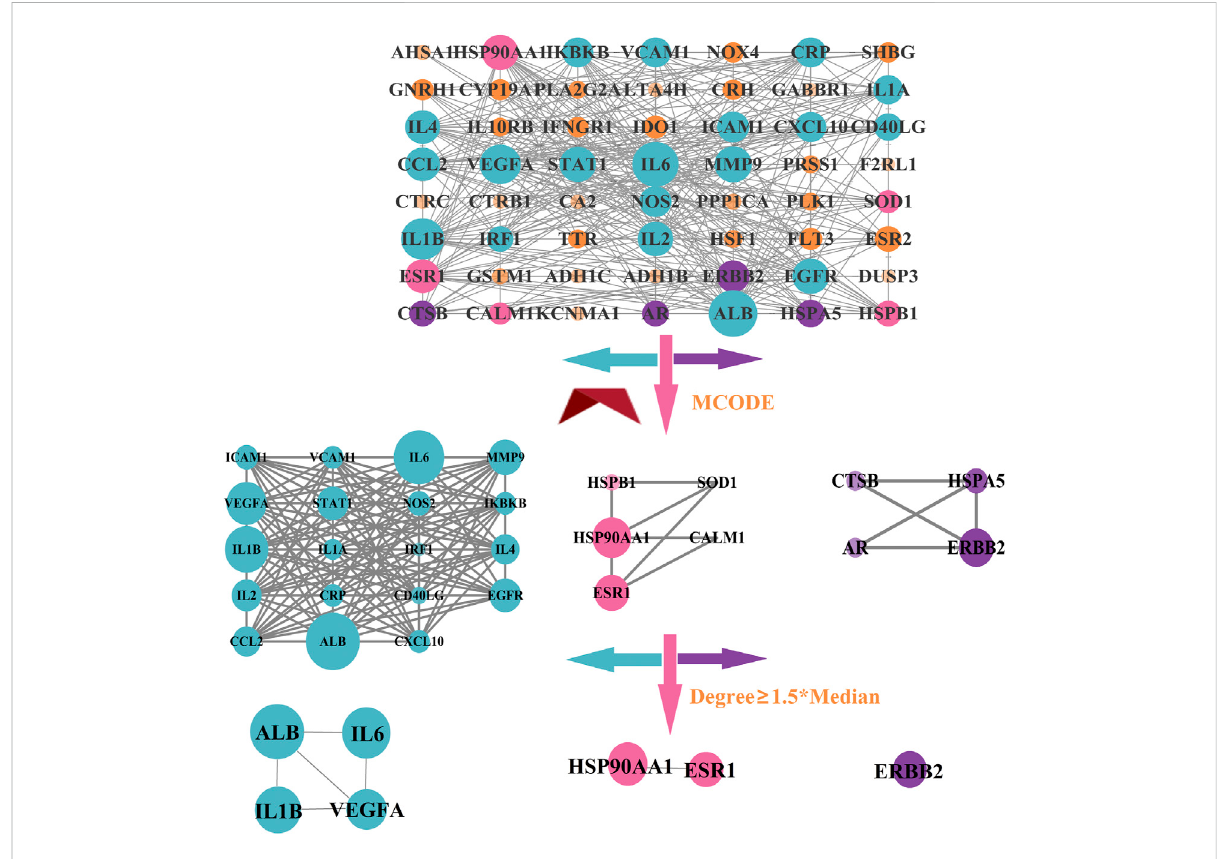
FIGURE 13 PPI network of intersection